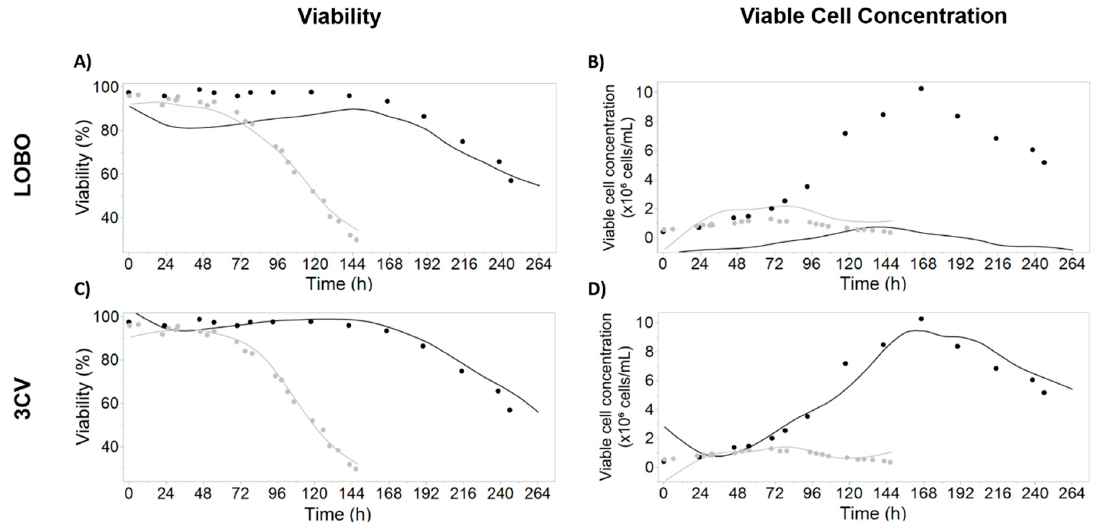
Figure 1. Viability (left) and viable cell concentration (right) predictions using leave one batch out (LOBO, top) and 3-fold cross-validation (3CV, bottom) models. Growth batch is represented in black and infected batch is colored in grey. The lines represent model-predicted values; the filled circles represent reference data; the empty circles were considered outliers and excluded from modeling. For LOBO models, the lines represent the prediction obtained with the model calibrated in the remaining batch. For 3CV models, the lines represent the model built using data from both batches. ( A ) Observed and predicted values for viability using LOBO for model validation; ( B ) Observed and predicted values for viable cell concentration using LOBO for model validation; ( C ) Observed and predicted values for viability using 3CV for model validation; ( D ) Observed and predicted values for viable cell concentration using 3CV for model validation. Model parameters and coefficients are presented in